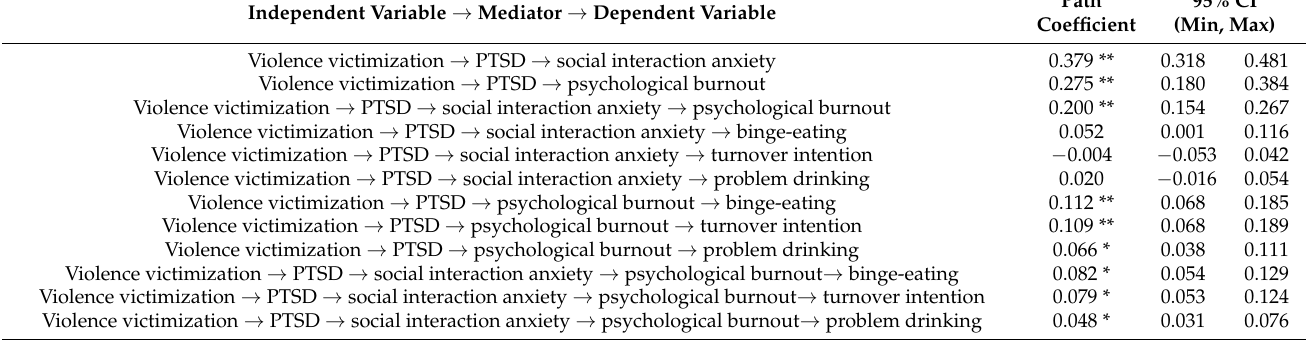
Table 2. Evaluation of the indirect